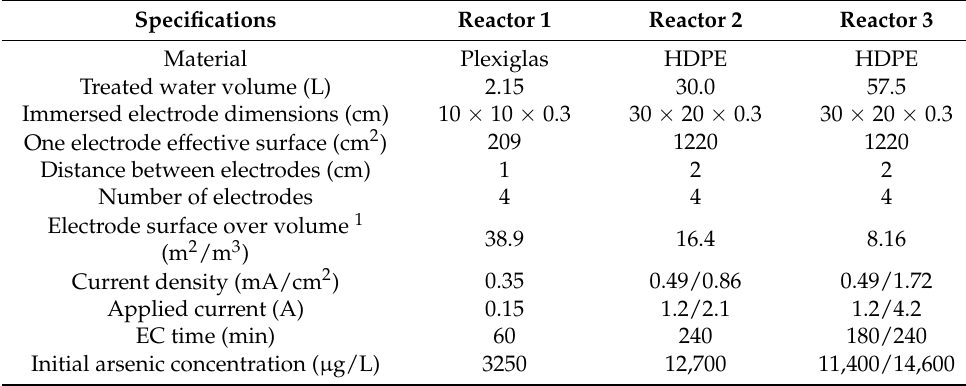
Table 2. Specification of the used EC Reactors and experimental